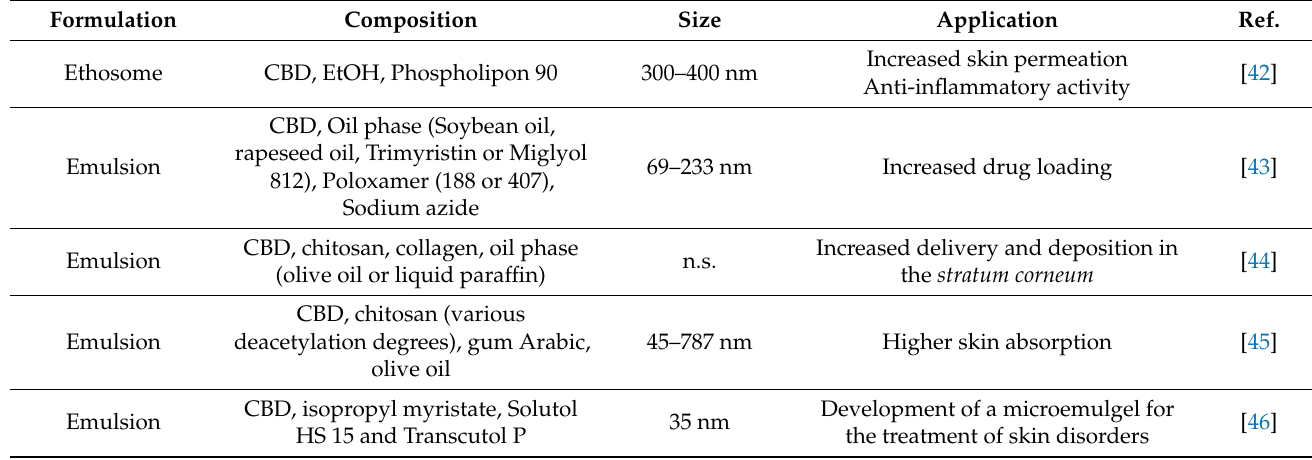
Table 2. Examples CBD-loaded lipid particles with potential for skin